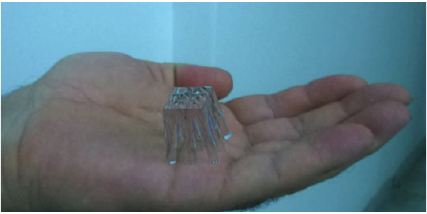
Figure 10: CAD prototype of